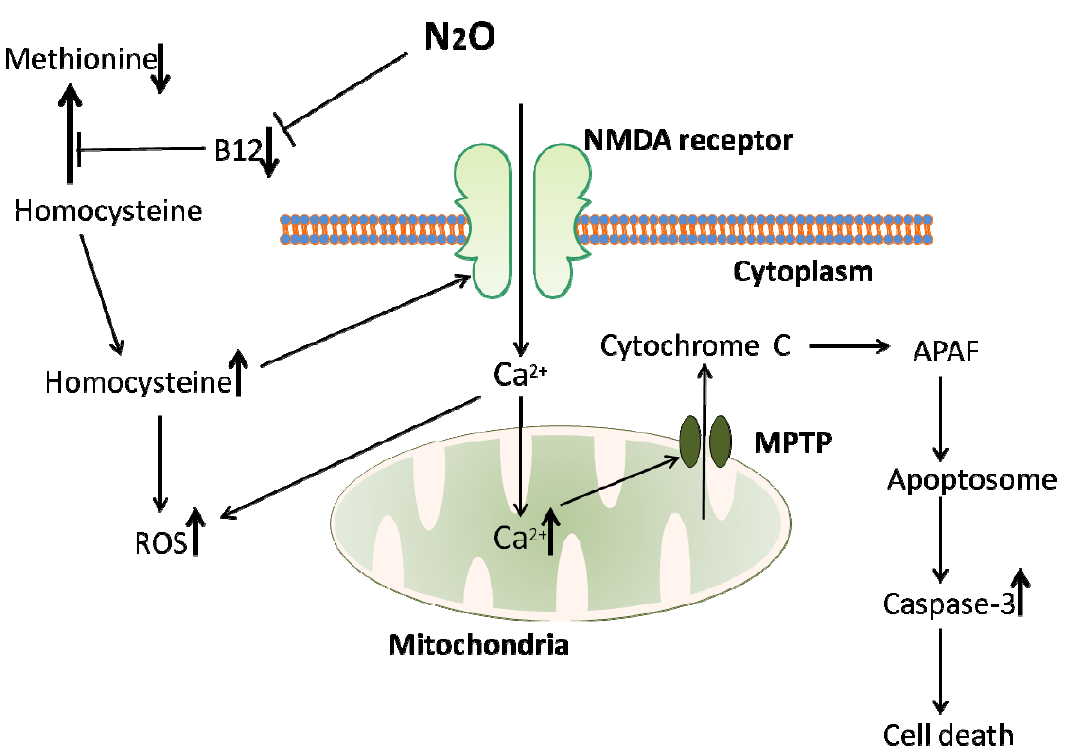
Figure 1. An overview of the homocysteine-mediated pathway of cell death induced by N O exposure. N O inhibits the action of vitamin B , an essential cofactor in the 2 2 12 conversion of homocysteine to methionine. This inhibition of vitamin B leads to 12 a buildup of homocysteine, a toxic amino acid. Homocysteine is toxic via at least two mechanisms; increasing reactive oxygen species (ROS) leading to eventual apoptotic cell death, and NMDA receptor activation. NMDA receptor activation can lead to an increase in ROS due to an influx of calcium into the cell. While N O is also an NMDA antagonist, 2 it is only effective during the course of anaesthetic exposure, while the rise in homocysteine levels induced by N O lasts for hours or even days, suggesting that 2 homocysteine mediated NMDA activation would play a larger role in cell death than N O 2 antagonism could